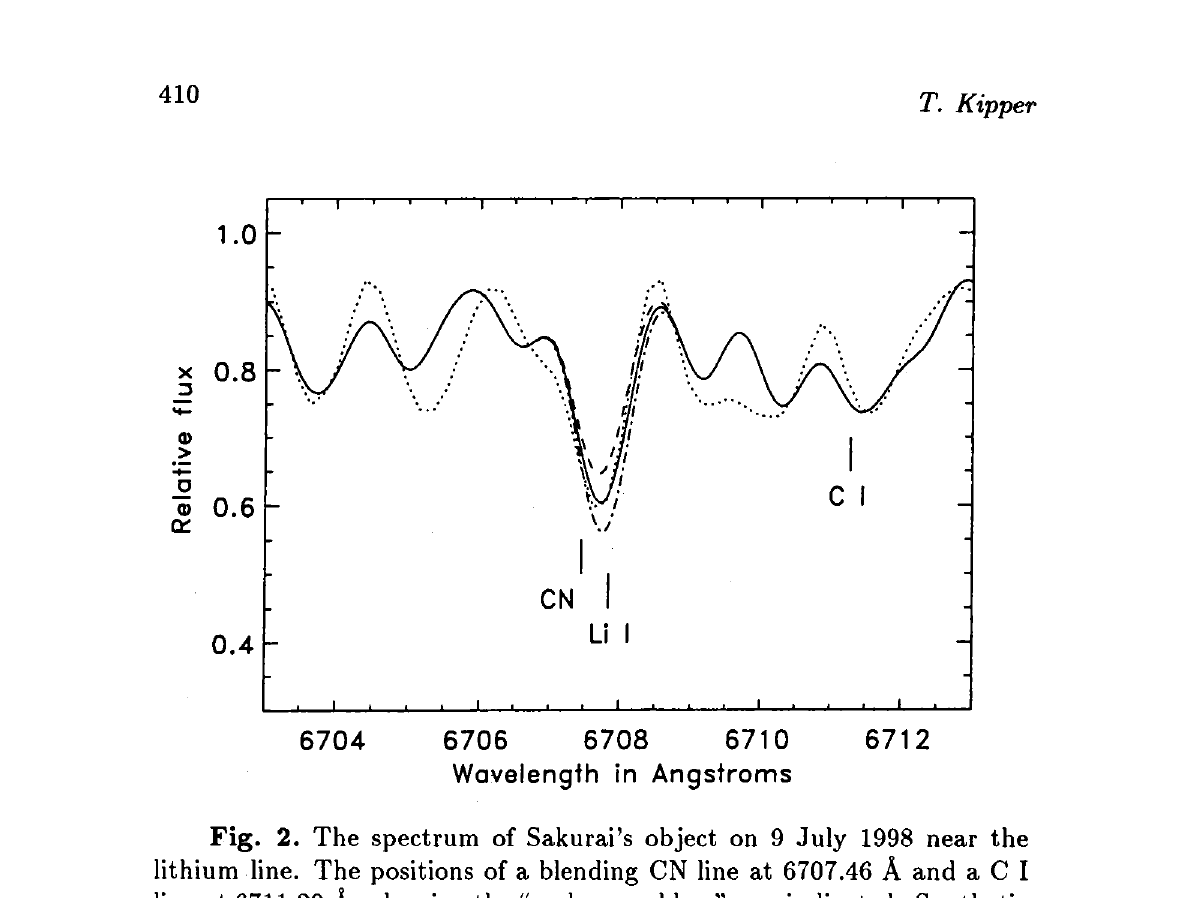
Fig. 2. The spectrum of Sakurai's object on 9 July 1998 near the lithium line. The positions of a blending CN line at 6707.46 A and a C I line at 6711.29 A , showing the "carbon problem", are indicated. Synthetic spectra with the Li abundances (normalized to log E //¿Ci = 12.15) 2.8, 3.1 and 3.4 dex are shown, assuming